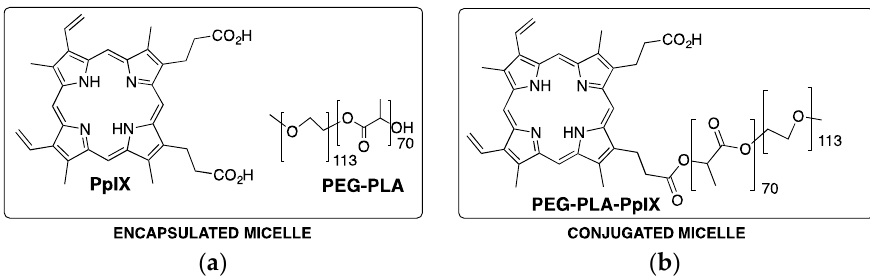
Figure 4. PEG-PLA and photosensitizer ( a ) and PEG-PLA-photosensitizer ( b ) structures used for the preparation of encapsulated and conjugated micelles, respectively.